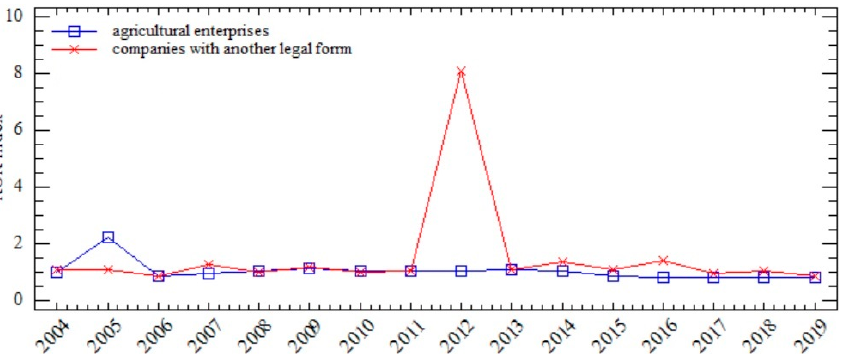
Figure 3. Development of the average value of the RCR index depending on the legal form in the period 2004–2019.